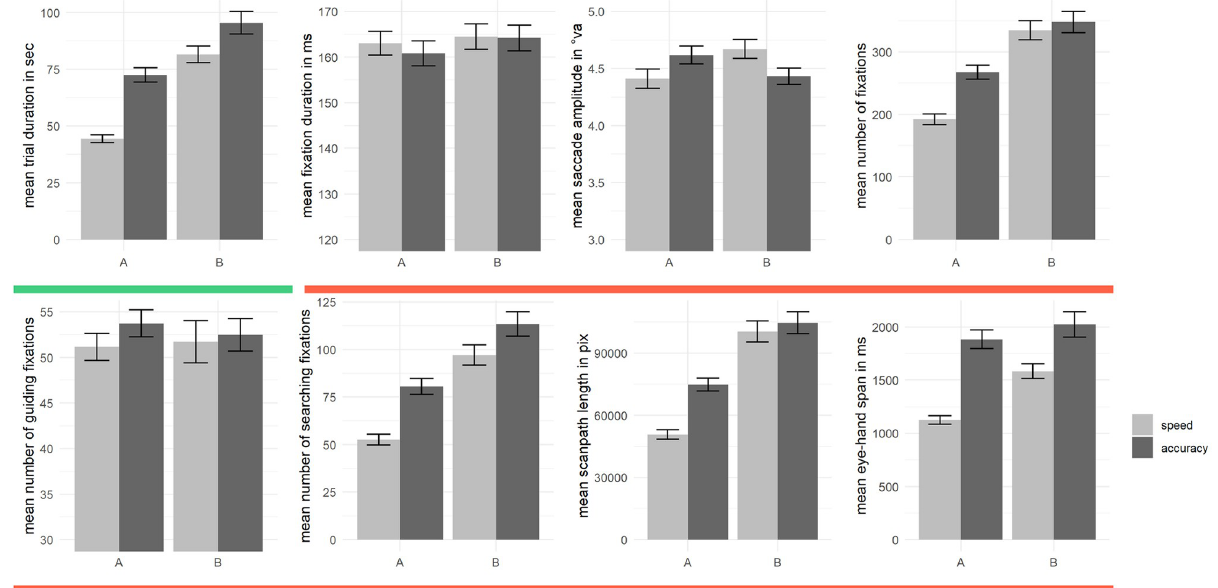
Fig 2. Test scores in TMT-A/-B under speed/accuracy instructions. Bar plots for the dependent variables across all conditions (test halves A and B; speed and accuracy instruction). Error bars represent the standard error of the mean. The red line underneath the plots indicates variables representing eye movement control measures. The green underneath the plots indicates variables representing classic TMT measures, i.e. trial duration.